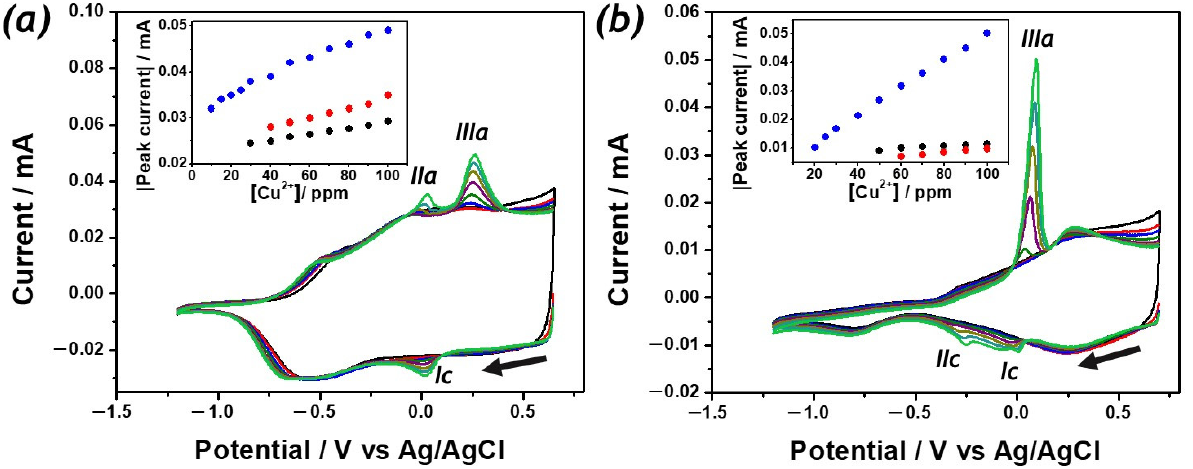
Figure 2. Potentiodynamic reduction at ( a ) PEDOT and ( b ) PXDOT electrodes of a 0.1 M LiClO 4 , acetate buffer (pH 4) aqueous solution at different Cu 2+ concentrations. Inset shows a plot of the peak current (absolute value) vs. the concentration of added copper for peak Ic (black dots), IIa (red dots), and IIIa (blue dots).